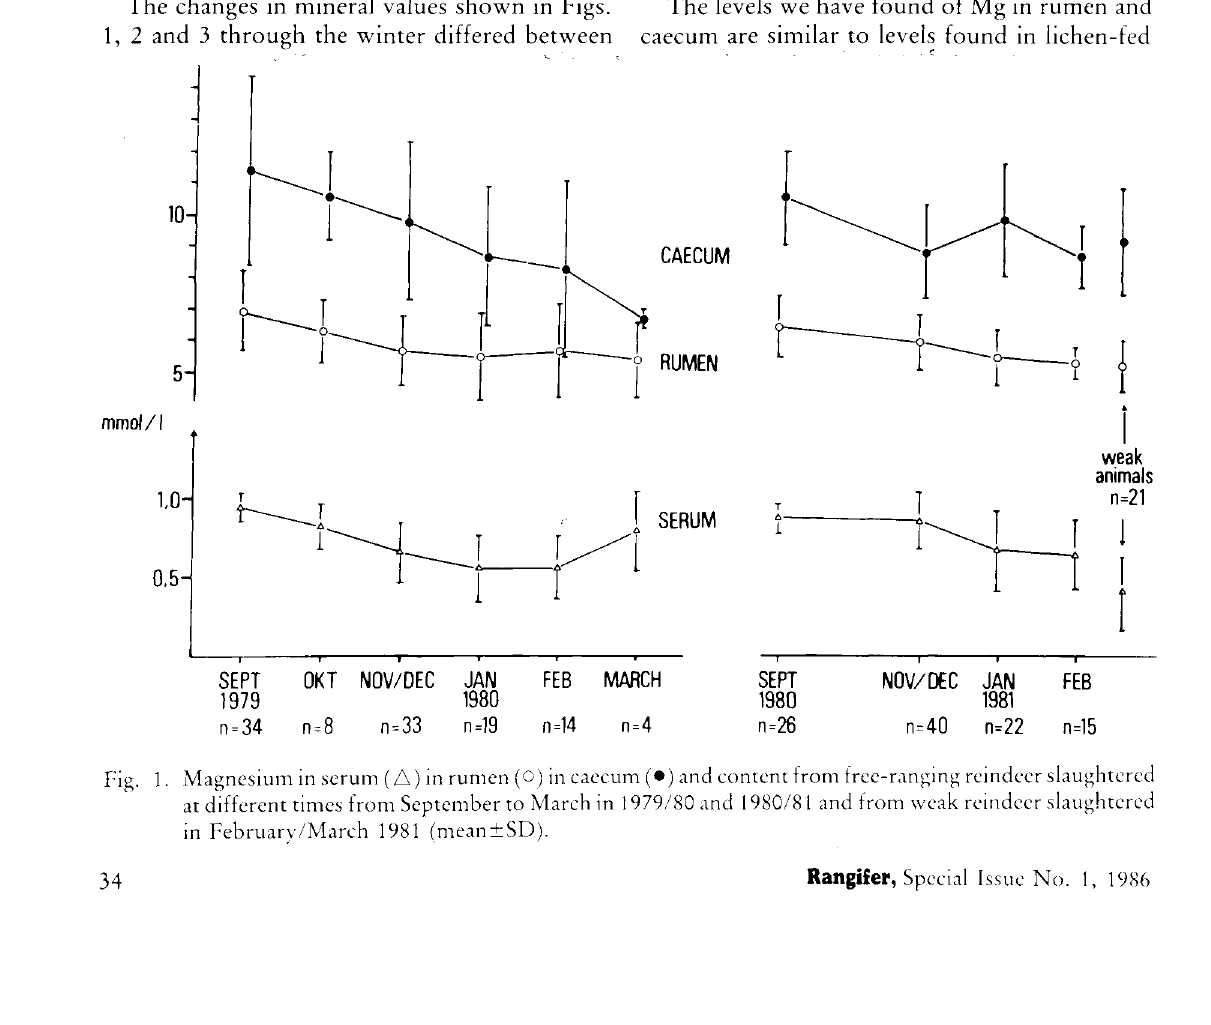
Fig. 1. Magnesium in serum (A) in rumen (o) in caecum (•) and content from free-ranging reindeer slaughtered at different times from September to March in 1979/80 and 1980/81 and from weak reindeer slaughtered in February/March 1981